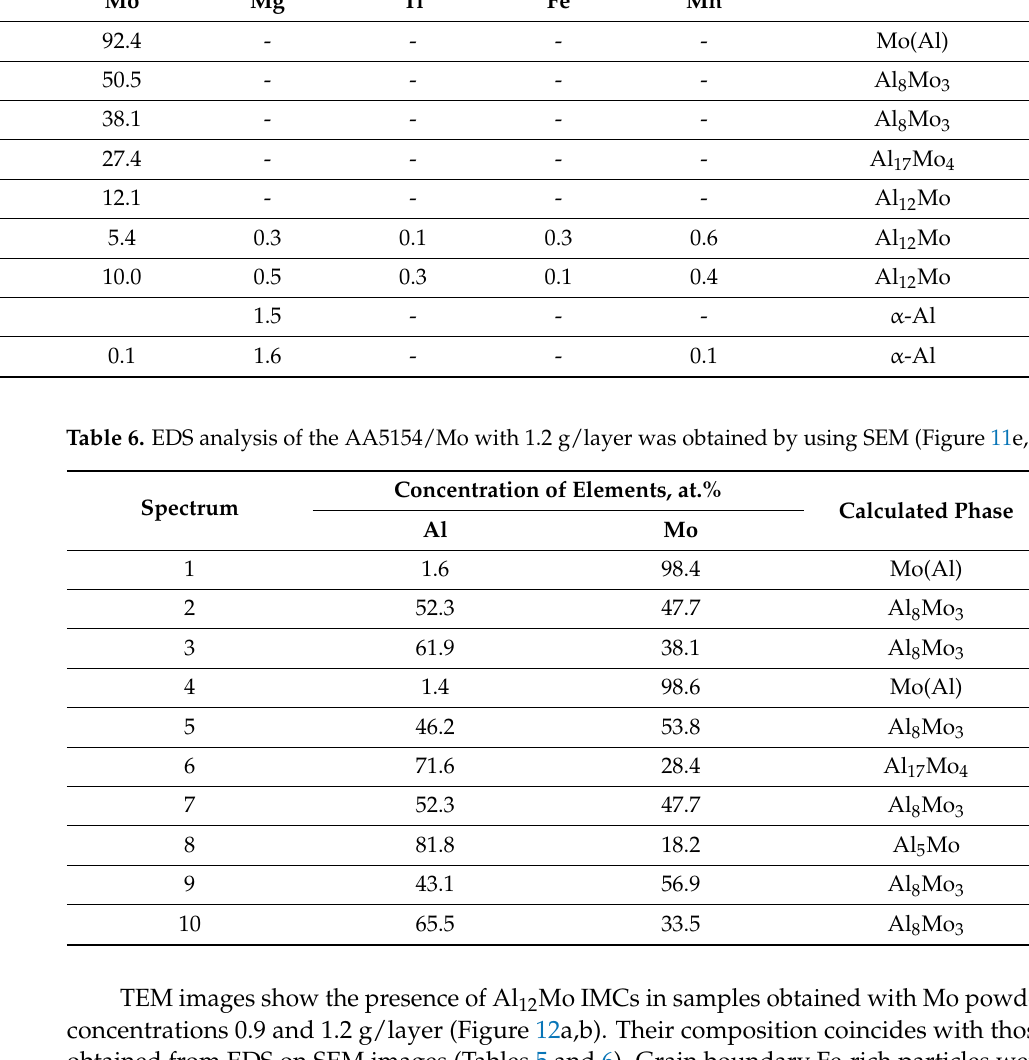
Table 5. EDS analysis of the AA5154/Mo with 0.9 g/layer was obtained by using SEM (Figure 10d,f). Concentration of Elements, at.% Spectrum